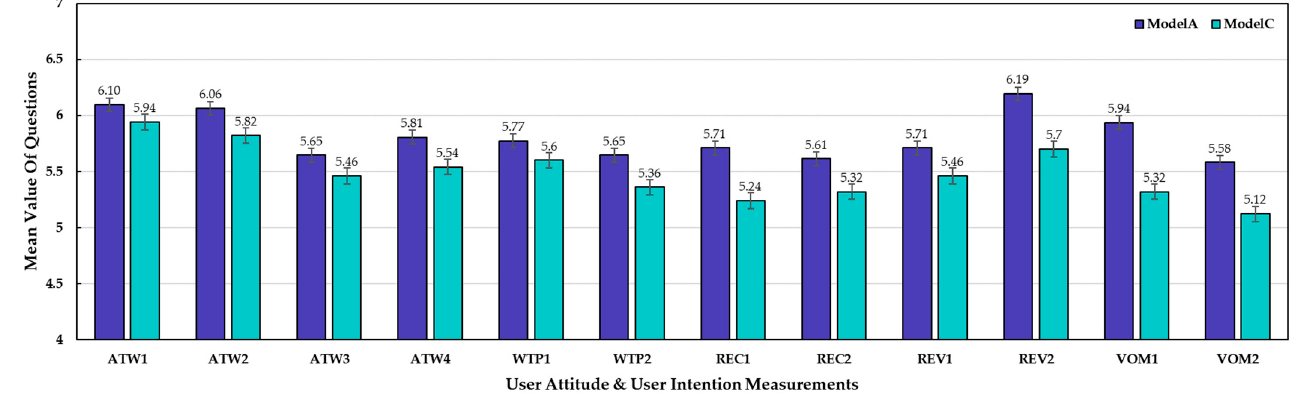
Figure 6. Comparison of user attitudes and user intentions between Model A and Model C.